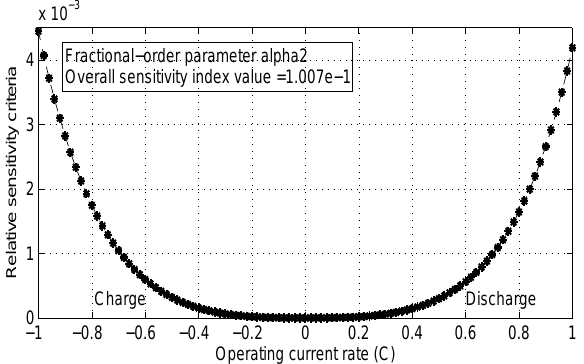
Figure 12. Sensitivity index values of highly sensitive parameter fractional-order factor α 2 at different operating current values.